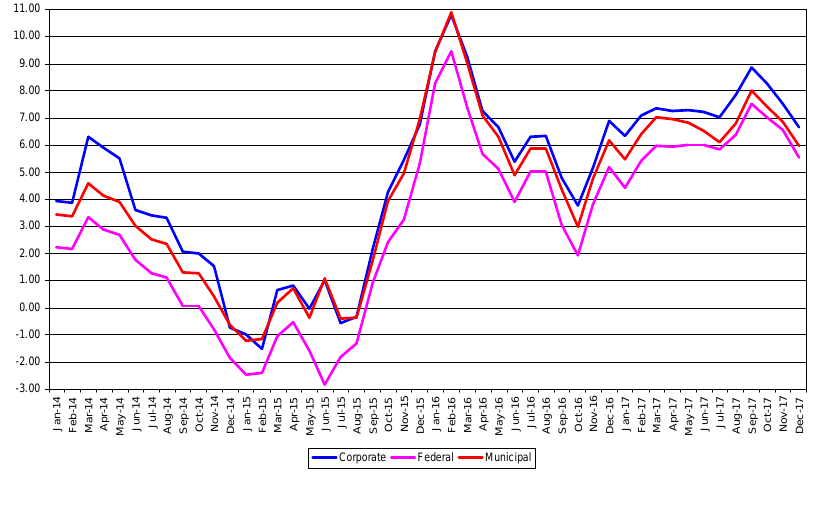
Figure 3. Dynamics of the stability index of the market for government bonds, municipal bonds and corporate